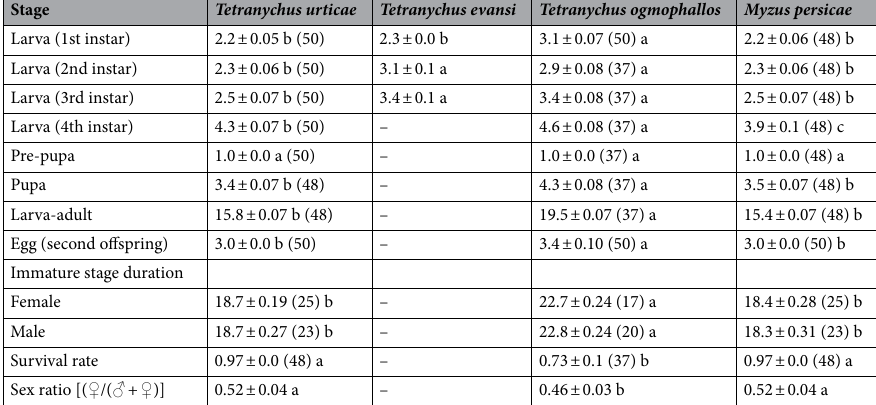
Table 1. Means (± SE) of duration (days) of immature stages of Eriopis connexa fed on Tetranychus urticae , Tetranychus evansi, Tetranychus ogmophallos , or Myzus persicae at 25 ± 1 °C, 70 ± 10% RH, and 12-h photoperiod. Numbers in parentheses: number of surviving specimens at each stage. Means followed by the same letters in a row do not differ from each other. Standard errors (SE) were estimated using 100,000 bootstrap resamplings and means were compared by paired bootstrap test (B = 100,000) based on 95% confidence interval of the difference between.